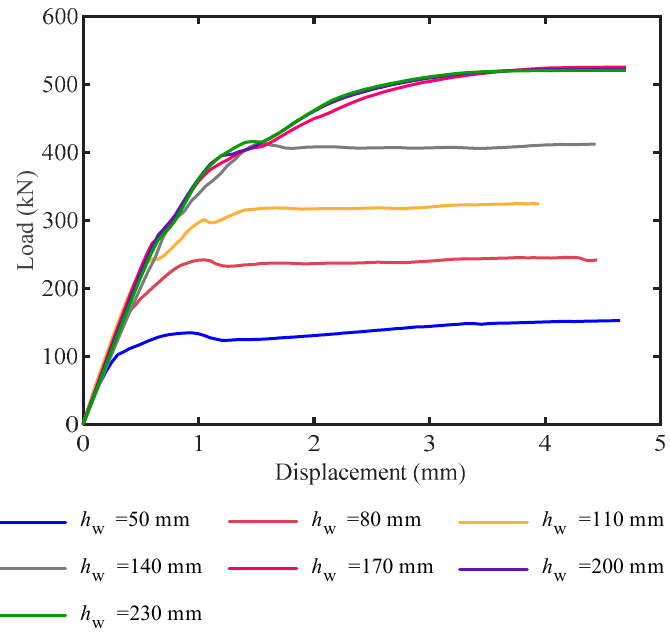
Figure 21. Influence of the web height of the T-stub connector.